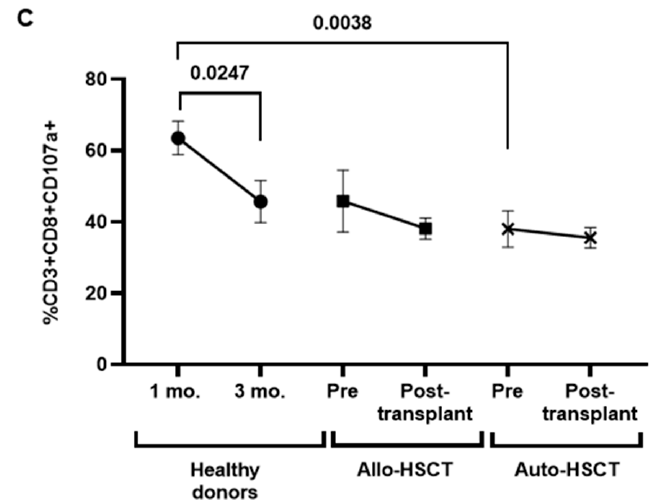
Figure 4. Characterization of total lymphocytes and CD8+ T cells in PBMCs from individuals with OHD before and after receiving Allo- or Auto-HSCT. ( A ) Total CD3+ T cells in PBMCs from individuals with Allo- or Auto-HSCT were evaluated by flow cytometry before and after HSCT. CD8+ cell count ( B ) and expression of CD107a in these cells ( C ) were determined in PBMCs from individuals with OHD, before and after HSCT, in comparison with healthy donors. Each dot in the graphs corresponds to mean ± SEM. Different cohorts are marked with the following symbols: Healthy donors (white circles), Allo-HSCT (black squares), and Auto-HSCT (cross). Statistical significance between groups was calculated using a one-way ANOVA test, and statistical significance within groups was calculated using a t